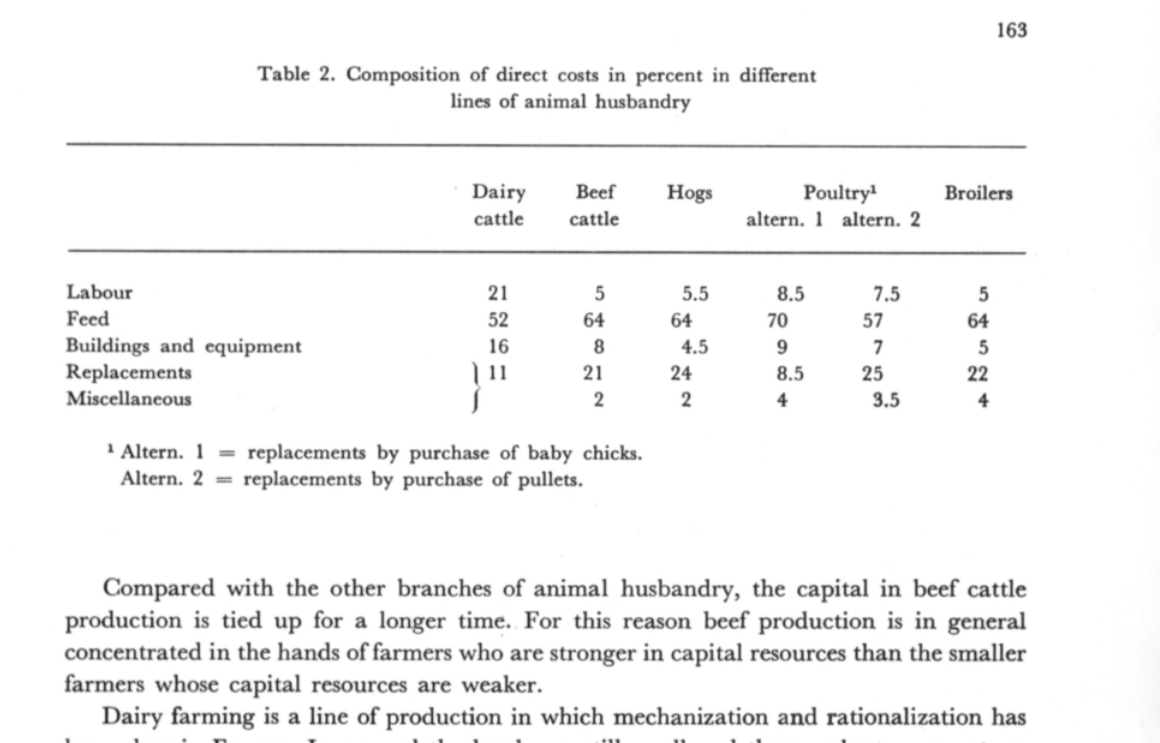
Table 2. Composition of direct costs in percent in different lines of animal husbandry